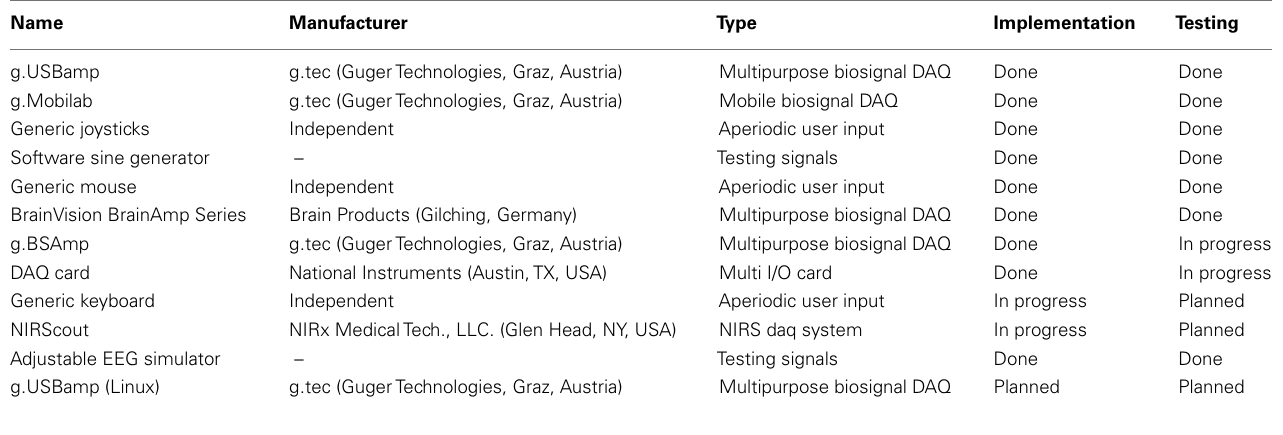
Table 1 | List of devices supported by the SignalServer (modified from Breitwieser et al.,